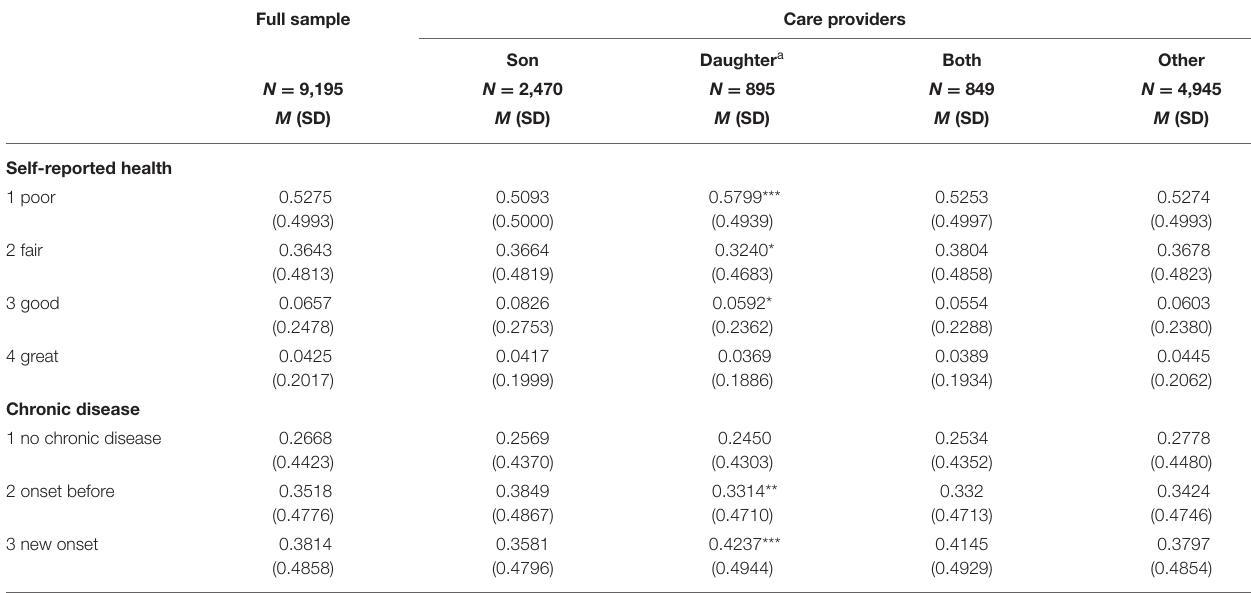
TABLE 2 | Health status by care providers.